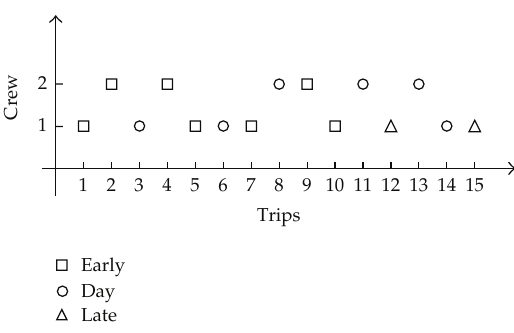
Figure 3: Decoding